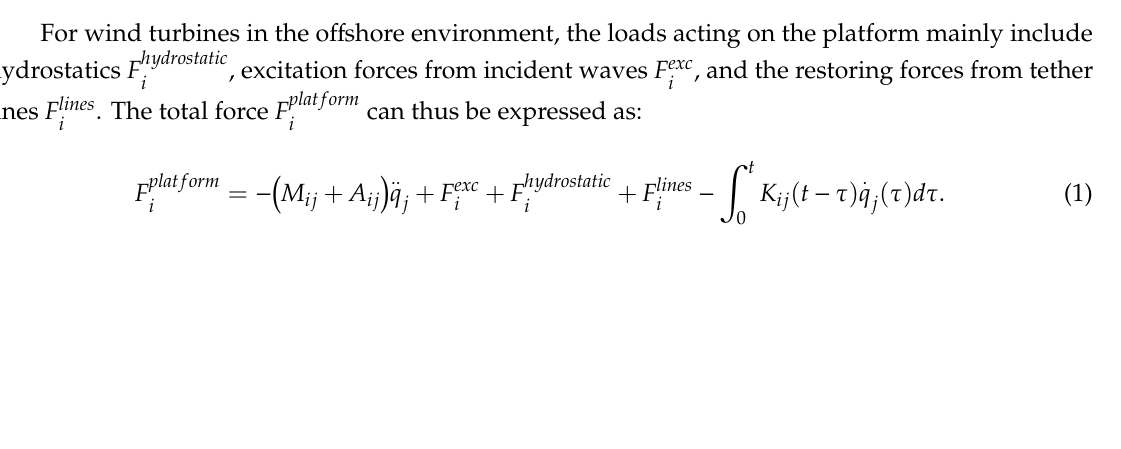
Figure 2. Six degrees of freedom motions of the oceanic floating offshore wind turbines (FOWT).